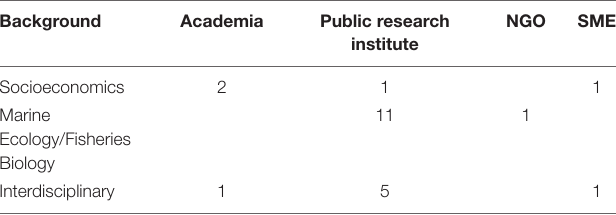
TABLE 1 | Expert’s scientific background and affiliation. NGO, non-governmental organization; SME, small and medium-sized enterprise; Interdisciplinary background, expert with experience in research that involves the combining of two or more academic disciplines.